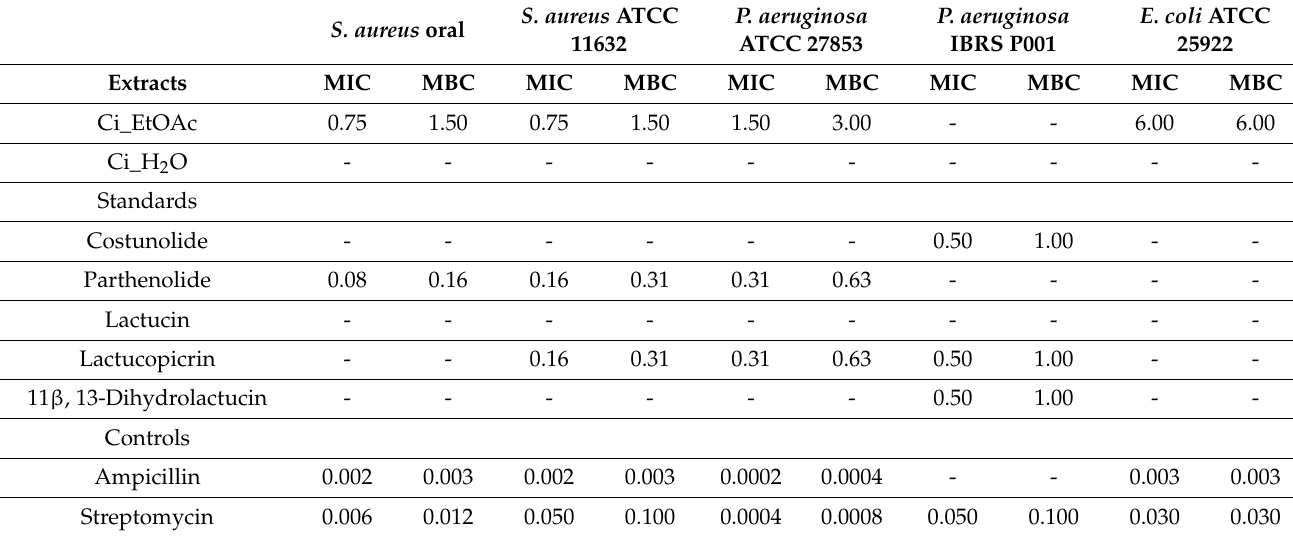
Table 3. Antibacterial activity of Ci_EtOAc and Ci_H 2 O and pure standard compounds (mg/mL). MIC, minimal inhibitory concentration; MBC, minimal bactericidal concentration.